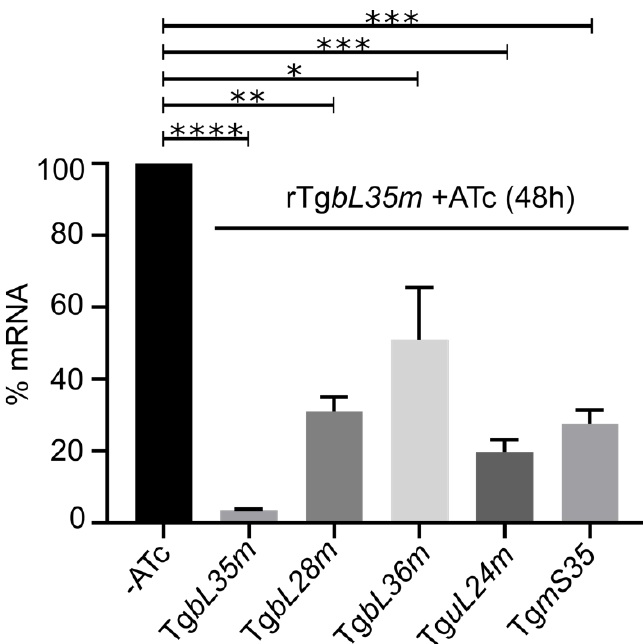
Figure 4. Depletion of Tg bL35m results in downregulation of other mitoribosomal subunit homologs. Bar graph depicting the transcript levels of Tg bL35m , Tg bL28m , Tg bL36m , Tg uL24m and Tg mS35 , analysed by RT-qPCR, from RNA sample collected at 48h of ATc treatment of the Tg bL35m depletion cell line. Transcript levels for all the above genes in the absence of ATc are normalized to 100% and this is presented as one bar for -ATC ( n = 3, bars represent mean ± SD, **** p < 0.0001, *** p ≤ 0.0009, ** p = 0.0011, * p = 0.0284; analysed using unpaired t -test). These finding show reduced expression of genes encoding mitoribosomal proteins in respond to depletion of another mitoribosomal protein.